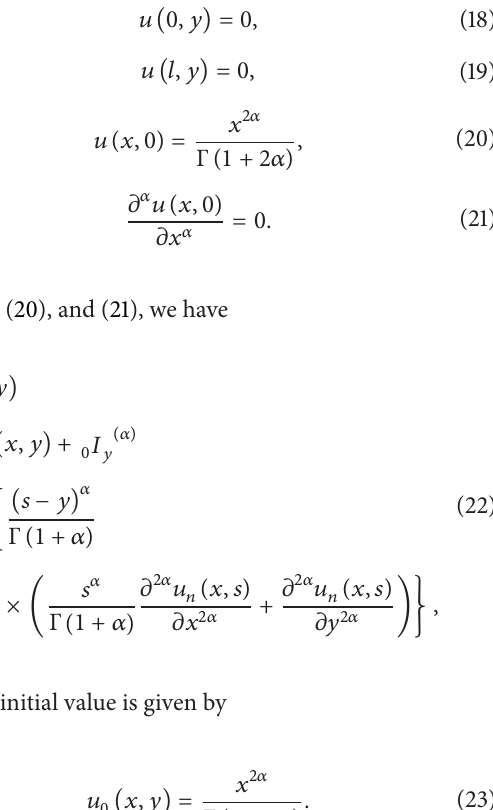
The second approximate term is